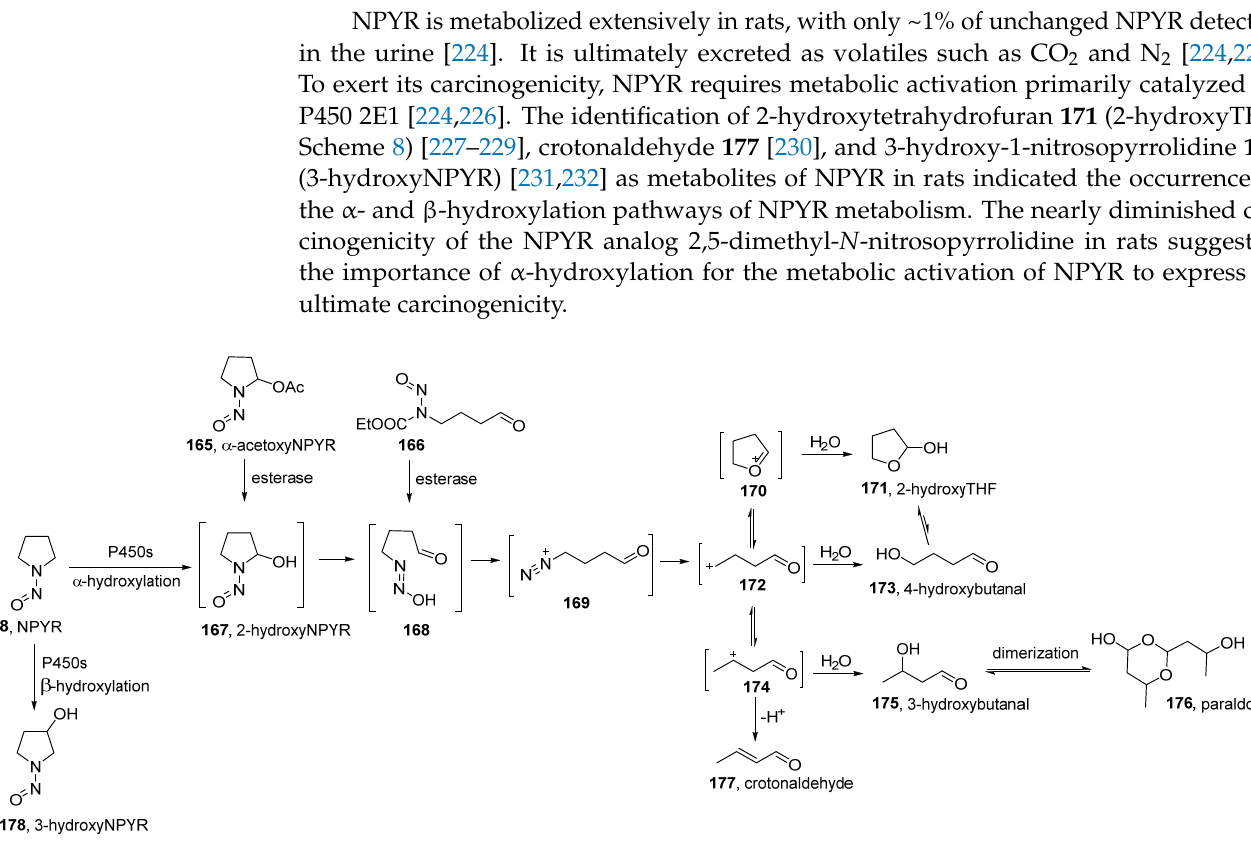
Scheme 8. Mechanisms of NPYR metabolic